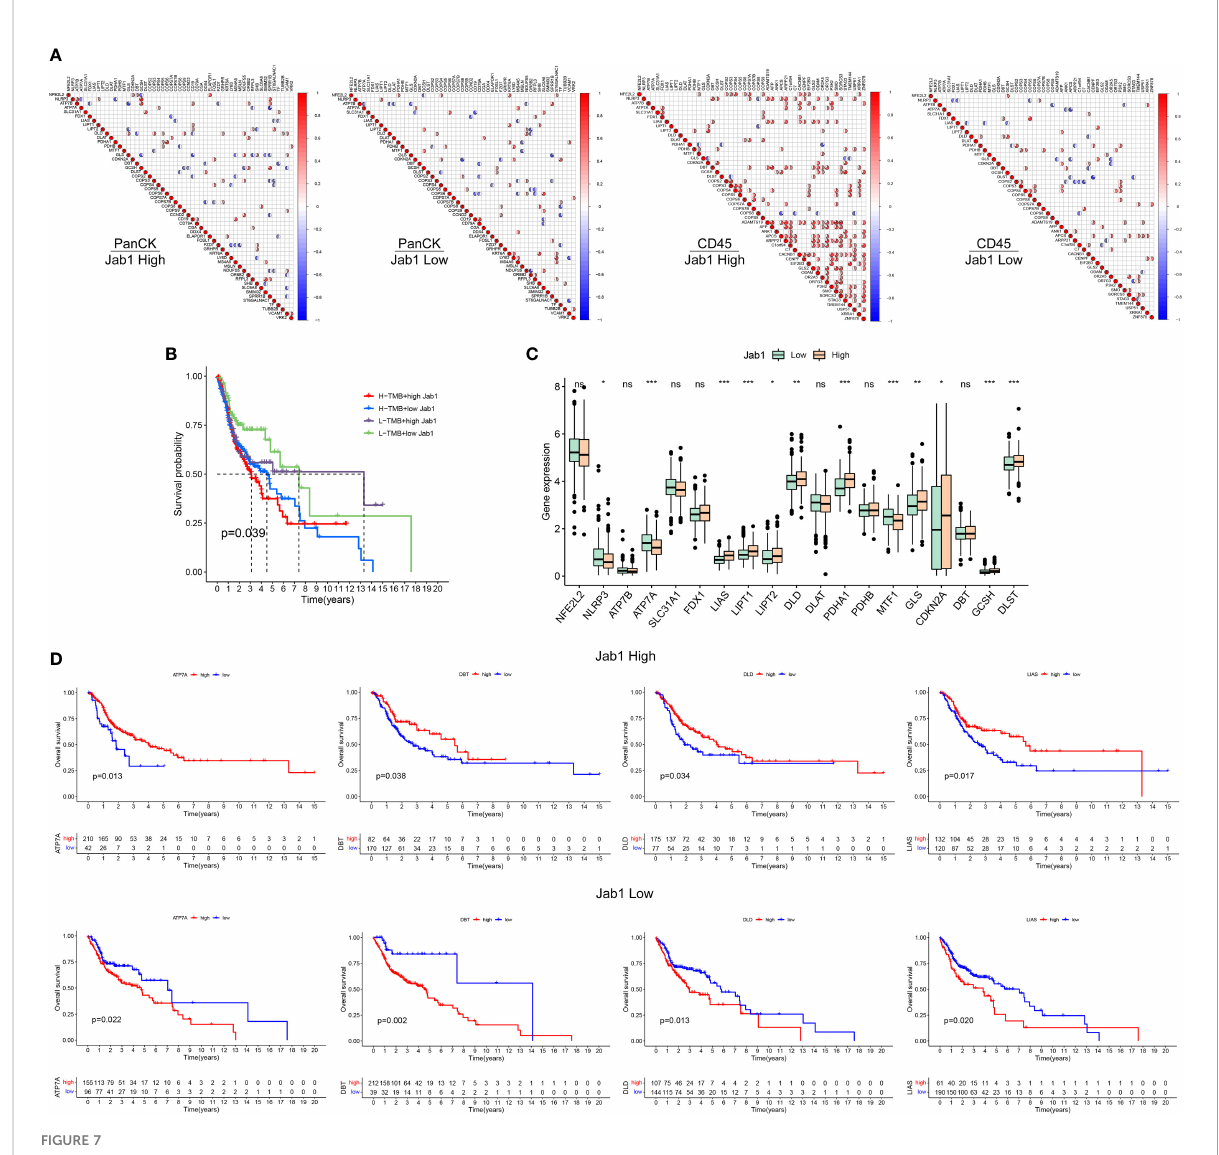
FIGURE 7 Differential analysis of cuproptosis related genes between the high and low Jab1 groups. (A) Correlation analysis of cuproptosis related genes, COPS family genes, and differential genes from the high and low Jab1 groups in different regions (tumor cell-enriched region and immune cell- enriched region) and different Jab1 subgroups: red (positive correlation), blue (negative correlation), sector direction (clockwise for positive correlation, and counterclockwise for negative correlation), only the sector area at p < 0.05 is shown. The darker the colors, the larger the sector areas, and the higher the correlations. (B) TMB and Jab1 affect survival of HNSCC patients. (C) Differential analysis of cuproptosis related genes between the high and low Jab1 groups. (D) Cuproptosis related genes and Jab1 affect the survival of HNSCC patients. *p<0.05, **p<0.01, ***p<0.001, ns, not signi fi